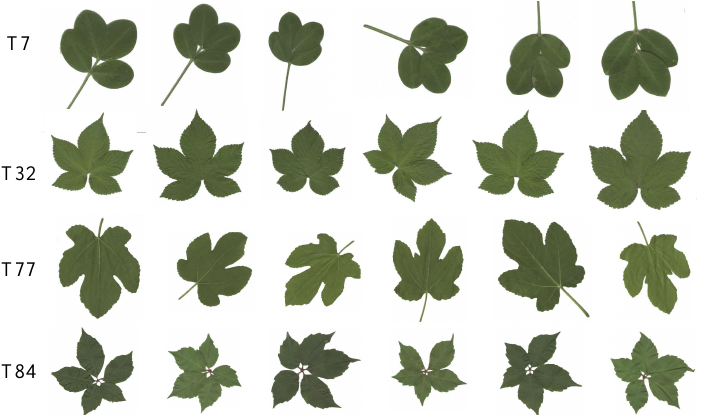
Figure 10. Example images from CVIP100 dataset; four species are shown. Table 8. Classification accuracy (%) comparison on CVIP100 dataset with identical settings.